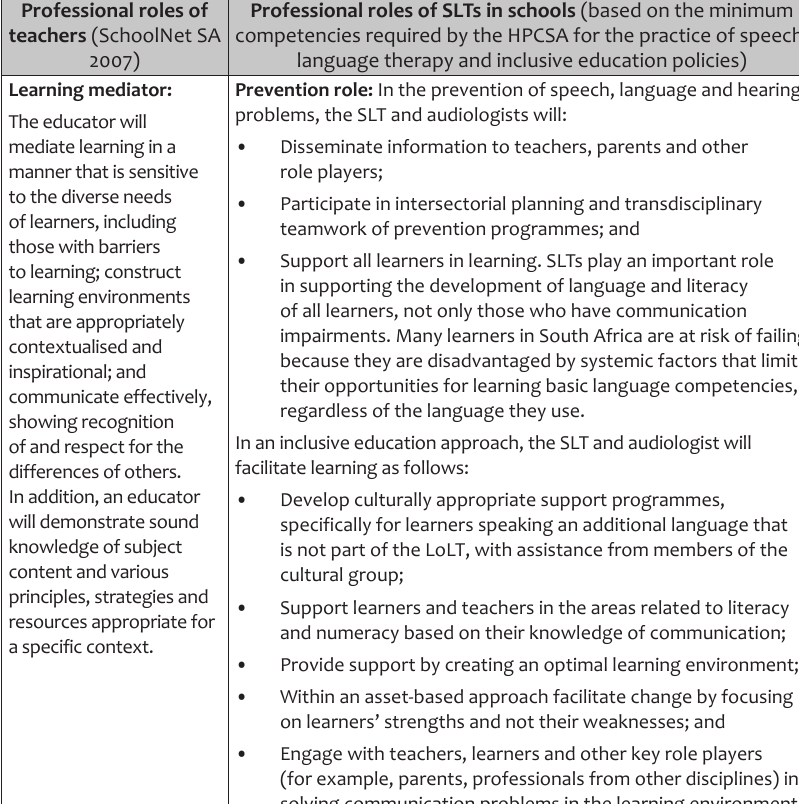
Table 1: Support of teachers by SLTs based on professional roles Professional roles of Professional roles of SLTs in schools (based on the minimum teachers (SchoolNet SA competencies required by the HPCSA for the practice of speech- 2007) language therapy and inclusive education